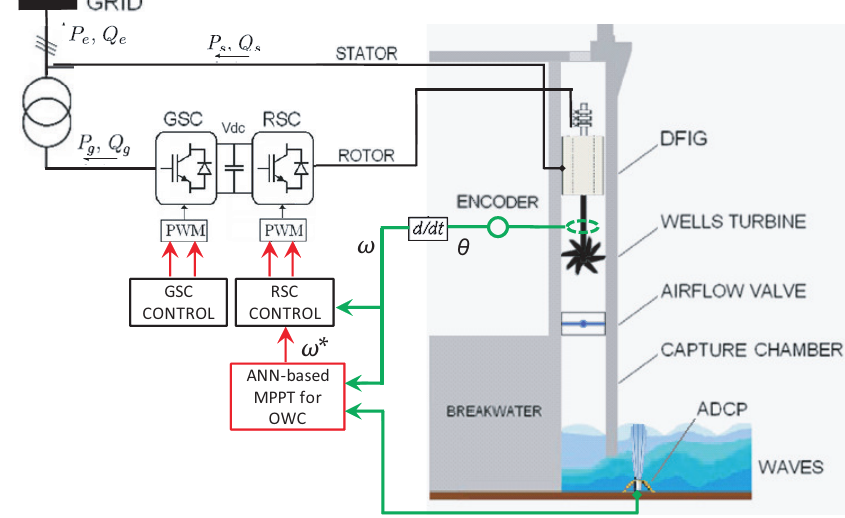
Figure 9. Rotational speed control scheme for a Wells turbine-based OWC wave power plant. Each side of the BTB converter controls a different aspect of the plant. The GSC adjusts the DC-link voltage and reactive power, whereas the RSC adjusts the active power and rotational